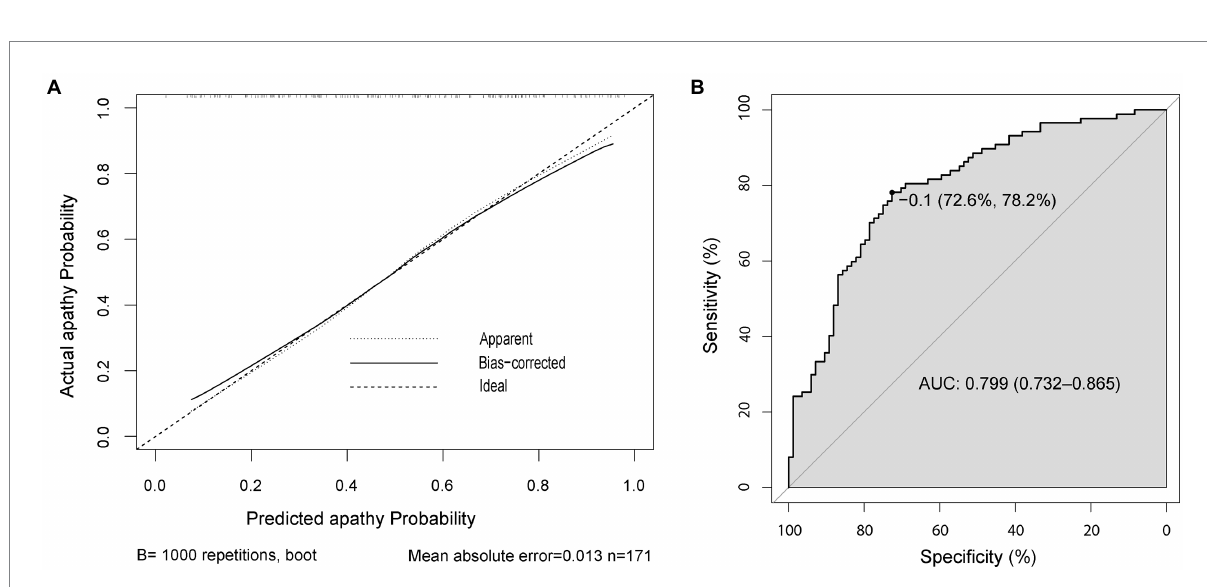
FIGURE 4 The calibration and accuracy of the nomogram. Calibration curve for predicting the probability of apathetic patients with PD (A) . ROC curve of the predictive model showing an AUC of 0.799 (95% CI = 0.732–0.865) (B) . AUC, area under the curve; CI, confidence interval; PD, Parkinson’s disease; ROC, receiver operating